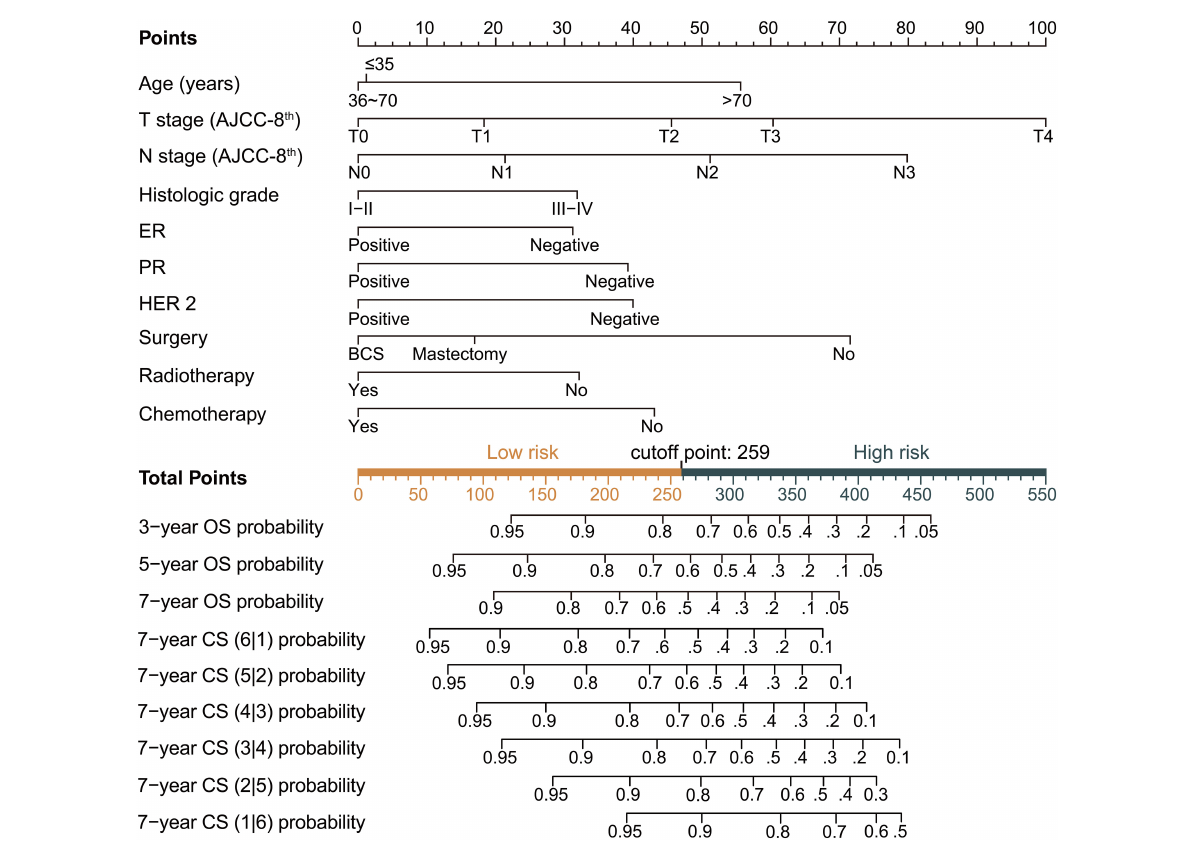
FIGURE4 Dynamic condition survival nomogram for predicting overall survival (OS) and conditional survival (CS) for patients with locally advanced breast cancer (LABC). (1) When using the nomogram, 10 predictors were quantified as “point” based on patient-specific factors and then the sum of the “point” corresponded to the “total point” below, which corresponded to the 3, 5, 7 year OS and 7 year CS; (2) The web version of the nomogram was available at: https://impcofmxd.shinyapps.io/LABC/; (3) The optimal cut-off total point calculated from the maximum standardized log-rank statistic was 259, which divided the patients into high-risk group and low-risk